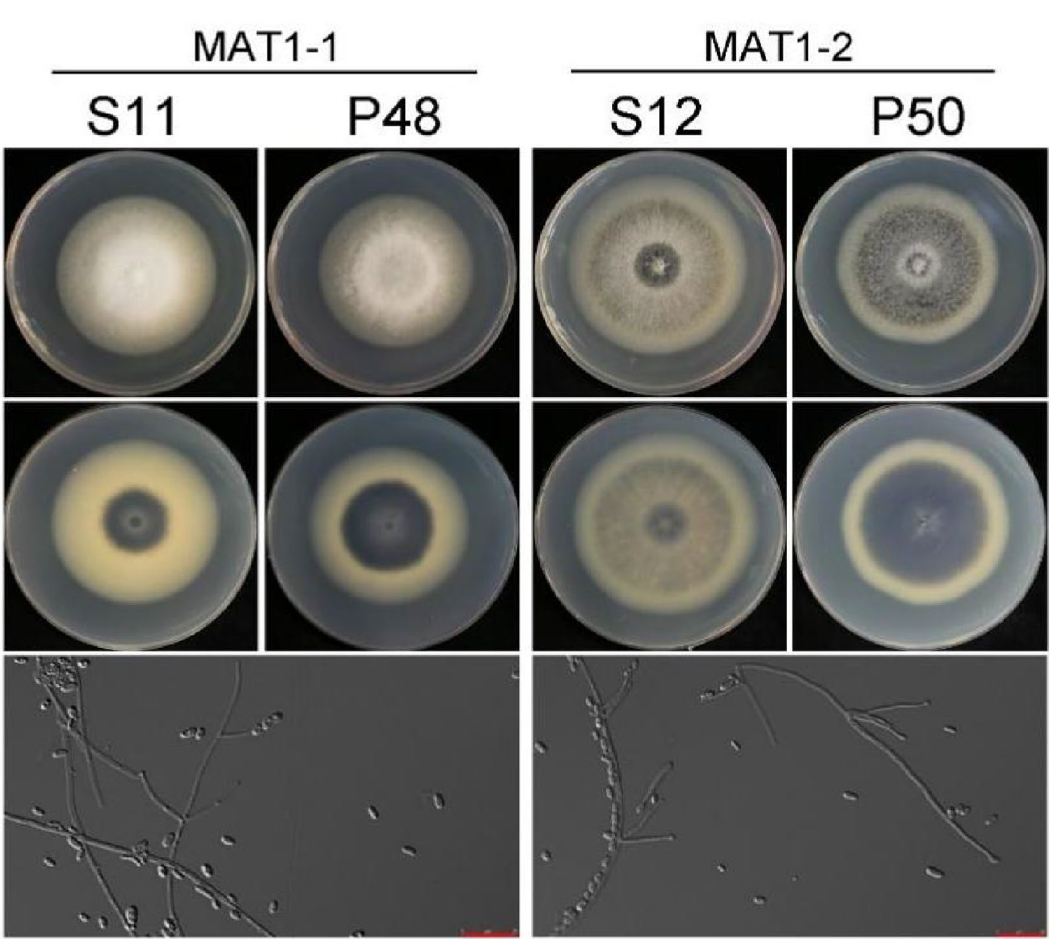
Figure 4. Physiological and morphological observation of V. dahliae isolates. Macro- and micro-observations of the two potato isolates. S11 and S12 were isolated from sunflower plants, while P48 and P50 were isolated from potato plants. Micro observation of isolates below has a magnification of 20